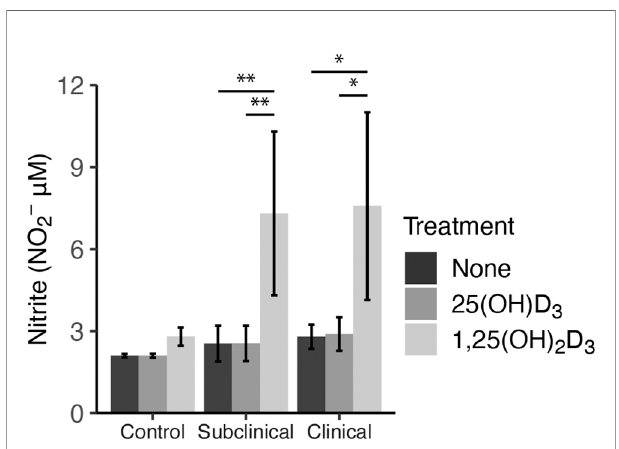
FIGURE 6 | Nitrite production by monocyte-derived macrophages (MDMs) co-cultured with peripheral blood mononuclear cells (PBMCs) from naturally infected dairy cattle (clinical n=7, subclinical n=7) or noninfected controls (n=9). Peripheral blood mononuclear cells (PBMCs) isolated from whole blood were cultured 5-6 days to generate MDMs, pre-treated with vitamin D 3 presented in methods, then incubated 24 hrs with live MAP (10:1 MOI) ± 25 (OH)D 3 or ± 1,25(OH) 2 D 3 . Nitrite concentrations were determined from cell culture supernatants by competitive binding of sulfanilamide and NED solutions in the Griess assay. Absorbance was measured at 540 nm on a SpectraMax microplate reader. Data are presented as the mean ± SE and signi fi cance is de fi ned by *< 0.05, **< 0.01, ***<